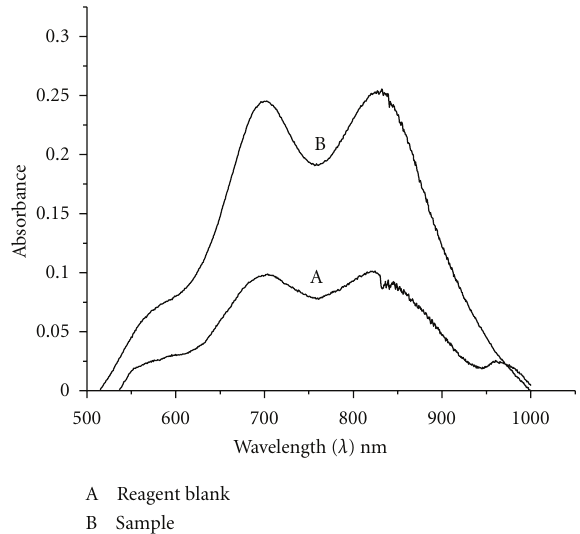
Figure 1: Absorption spectra of arsenomolybdenum blue complex after cloud point